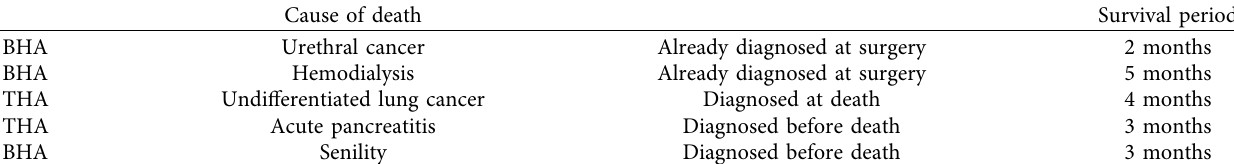
Table 3: Fatal complications in BHA group and THA group within 6 months